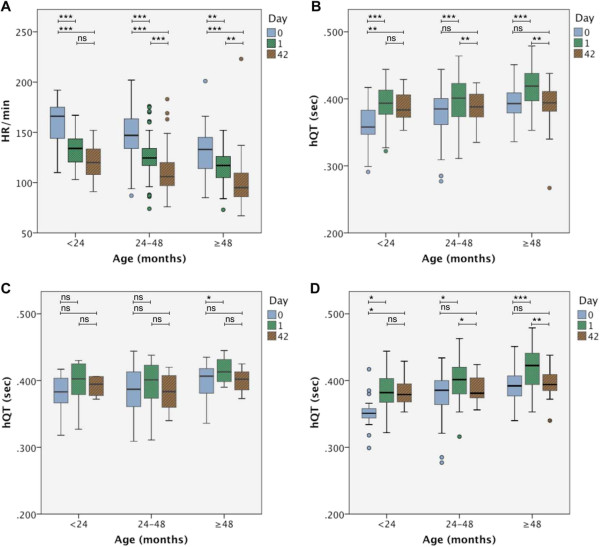
HR and hQT stratified by age groups (<2 years, 2 to <4 years, ≥ 4). Heart rate and hQT stratified by age group (<2 years, 2 to <4 years, ≥ 4 years) upon hospitalization in relation to day 1 and day 42: A heart rate, B hQT, C hQT for children with positive urine sample of 4-aminoquinoline drugs, D hQT for children without positive urine sample of 4-aminoquinoline drugs. The boxplots display medians and interquartile ranges. The age groups were compared by t-test: *P < 0.05, **P < 0.005, ***P < 0.001, ns not significant.